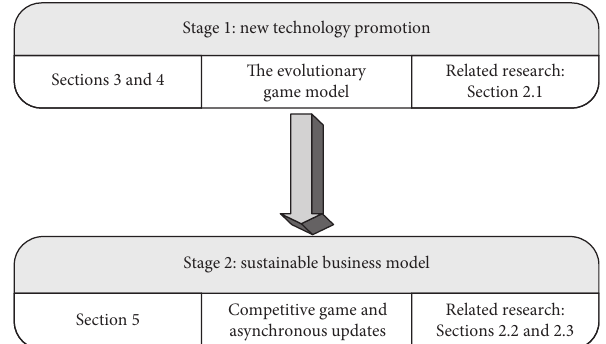
Figure 2: The article structure